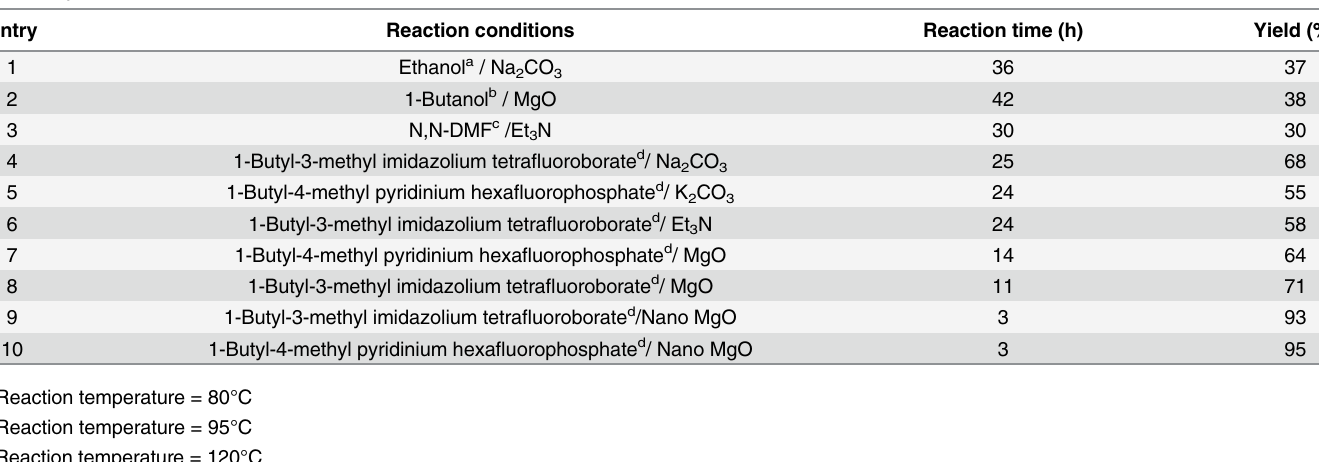
Table 1. Cyclocondensation of 5-Phenyl-2-amino-1,3,4-thiadiazole (2) with 1-Adamantyl bromomethylketone (1) under various reaction conditions to form title compounds. It can be seen that using nano-MgO as a base and employing ionic liquids instead of traditional organic solvents considerably increase yields above